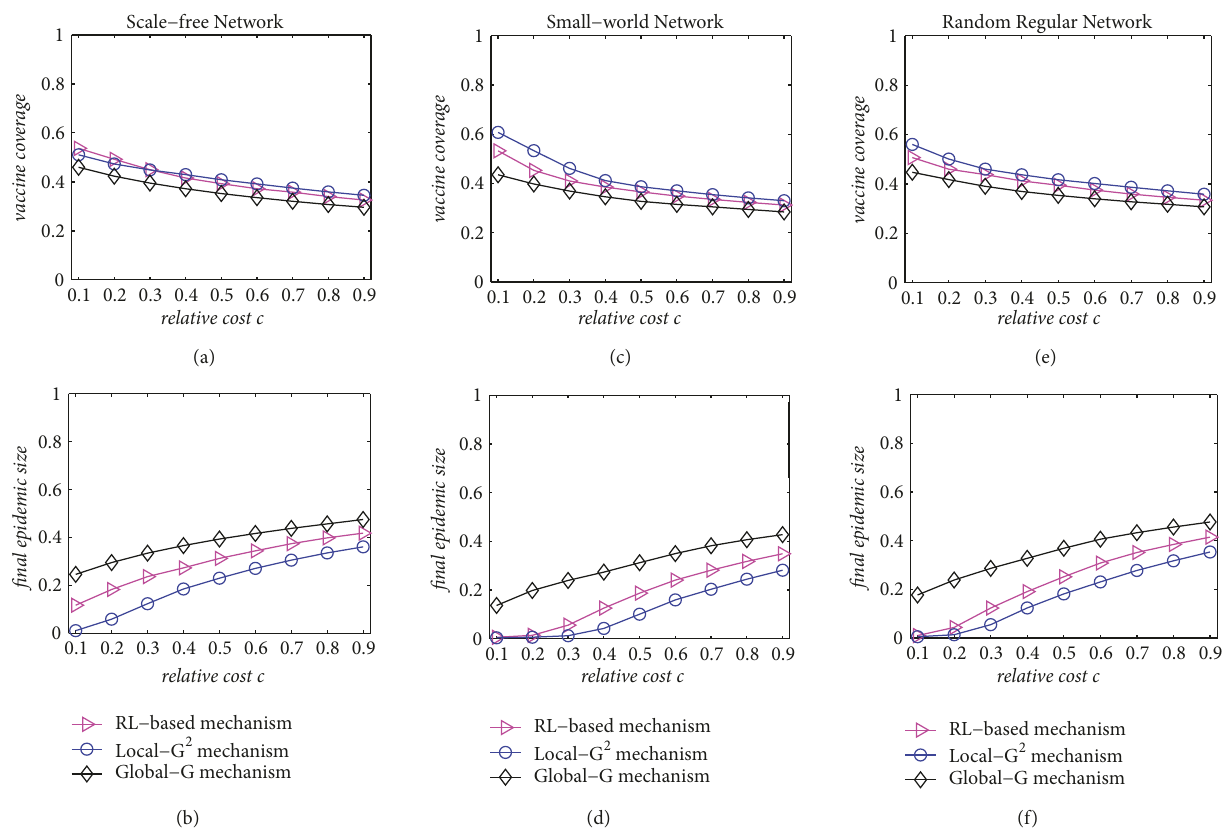
Figure 5: The final vaccine coverage and epidemic size of the RL-based mechanism compared with the local and global mechanisms in three types of social networks. Simulations are carried out on scale-free networks ((a) and (b)), small-world networks ((c) and (d)), and random regular networks ((e) and (f)). The results are averaged over 100 independent network simulations with network size 𝑁 = 10 , 000 and average degree ⟨𝑘⟩ = 4